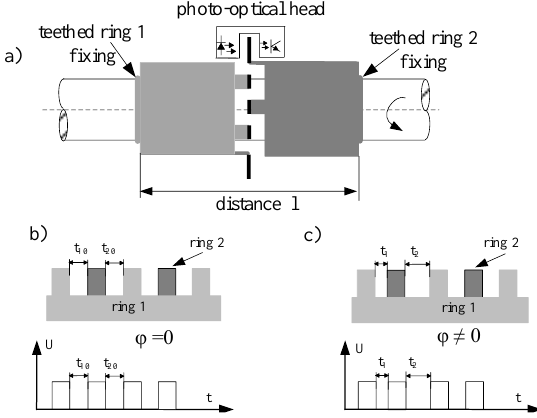
Figure 6. Photo-optical method for torque measurement, ( a ) concept of torque measurement, ( b ) relation between teeth of two rings and electrical signal for torsion angle ϕ = 0, ( c ) relation between teeth of two rings and electrical signal for torsion angle ϕ ≠ 0.